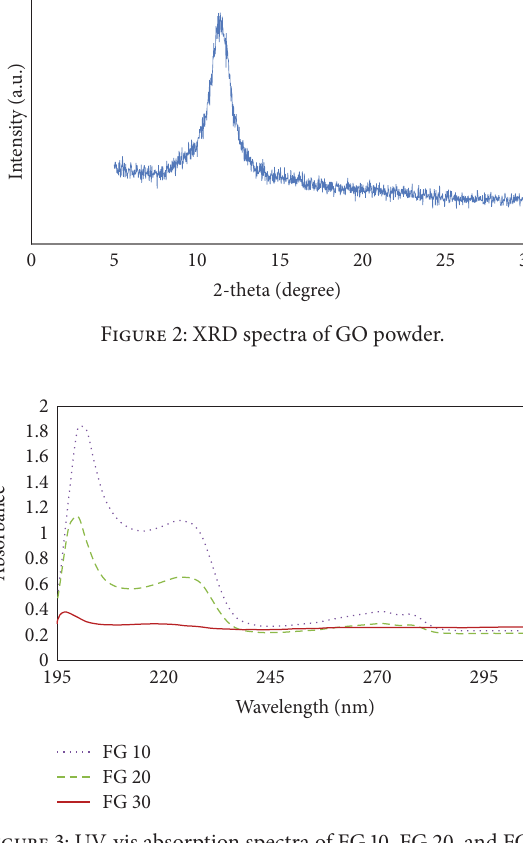
1638 cm −1 corresponds to the vibrational mode of the ketone groups ( − C=O). Another peak at approximately 1382 cm assigned to a (C–O) vibrational mode. Finally, the peak at approximately 1112 cm −1 arises from epoxide groups (C–O– C). Peaks below 900 cm −1 are not usually interpreted because they represent too complex a structural signature [28].